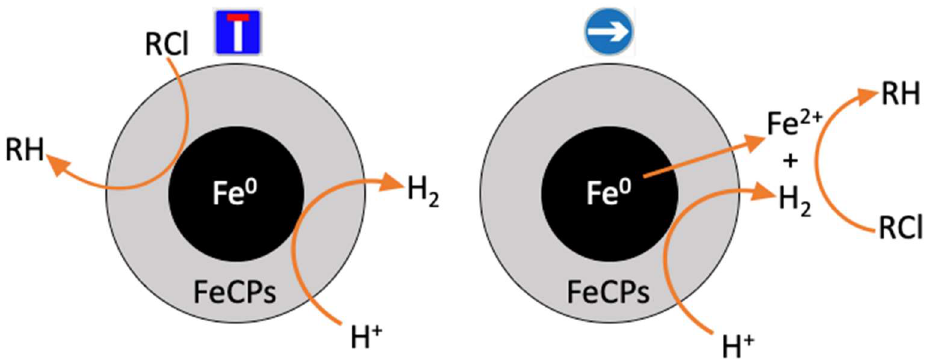
Figure 1. Schematic of the core/shell structure of the Fe 0 /H 2 O system. The following features are labeled: (i) (left) Fe 0 /FeCPs interface, (ii) FeCPs/H 2 O interface, (right) reduction of water (H + ) by Fe 0 , and (iv) reduction of RCl by Fe 2+ and H 2 .